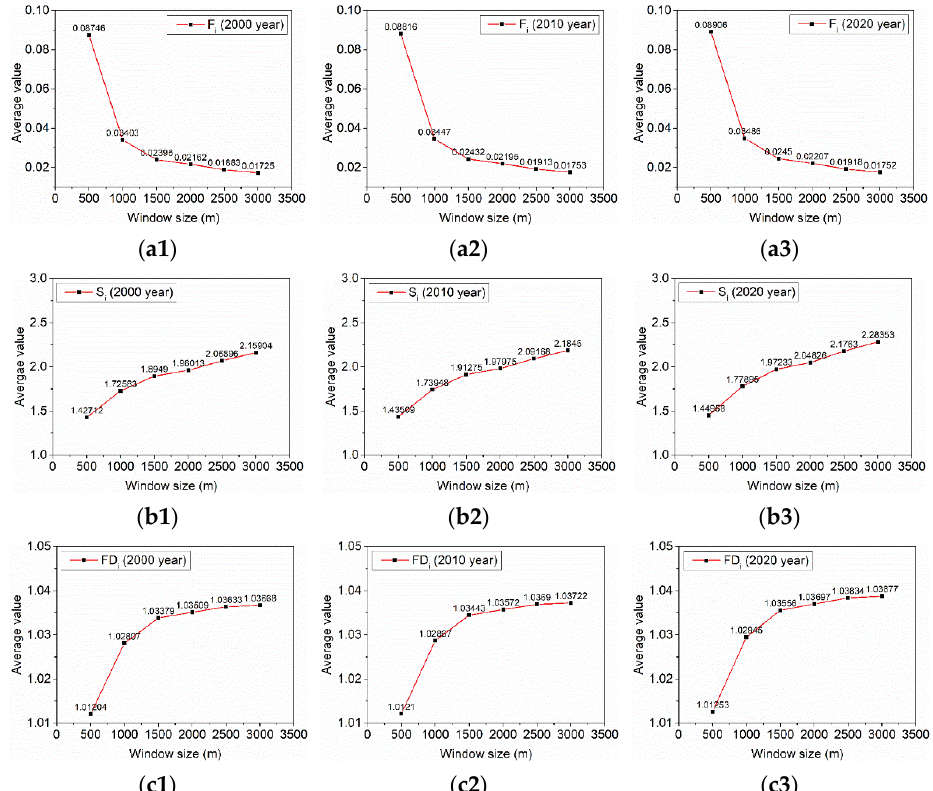
Figure 4. ( a1 – a3 ) are F i index average value change with different moving window sizes in 2000, 2010, and 2020, respectively. ( b1 – b3 ) are the S i average value index that change with different moving window sizes in 2000, 2010, and 2020, respectively. ( c1 – c3 ) are the FD i average value index that change with different moving window size in 2000, 2010, and 2020, respectively.